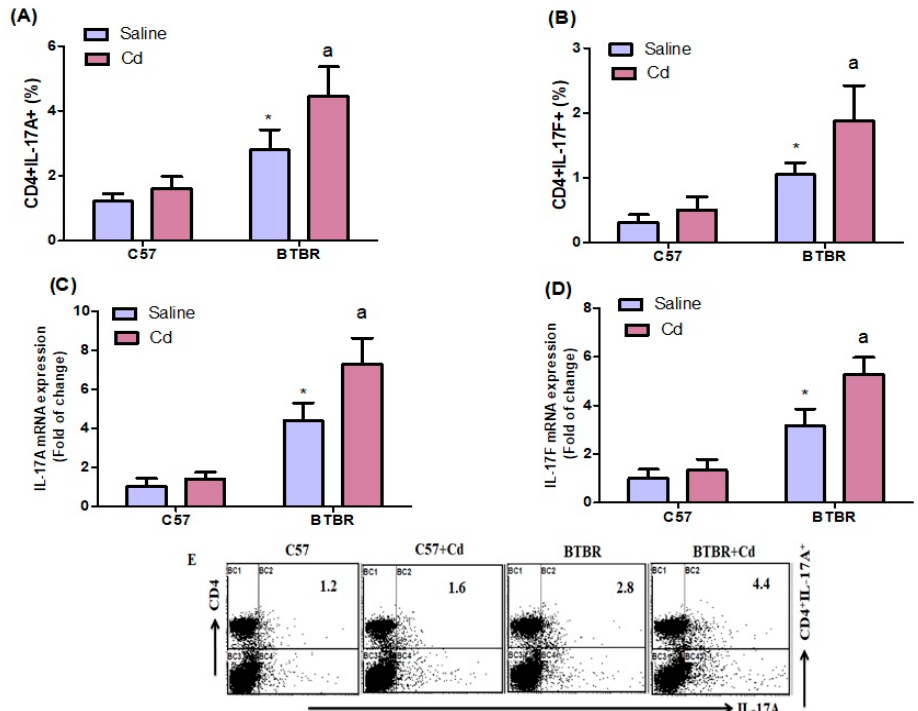
Figure 2. Effects of oral Cd exposure on IL-17A and IL-17F in BTBR and C57 mice. Spleen CD4 + T cells expressing ( A ) IL-17A and ( B ) IL-17F. RT-PCR analysis of IL-17A ( C ) and IL-17F ( D ) mRNA expression in brain tissue. ( E ) Representative FSC-SSC dot plots of CD4 + IL-17A + cells were obtained from each mouse spleen. BTBR and C57 mice were administered Cd (5 mg/kg/day) or saline only (control) daily for six weeks. All data are shown as mean ± SD ( n = 6/group). Different letter indicate significant difference. * p < 0.05 vs. saline-treated C57 mice, ap < 0.05 vs. saline-treated BTBR mice; two-way ANOVA with Tukey’s test.